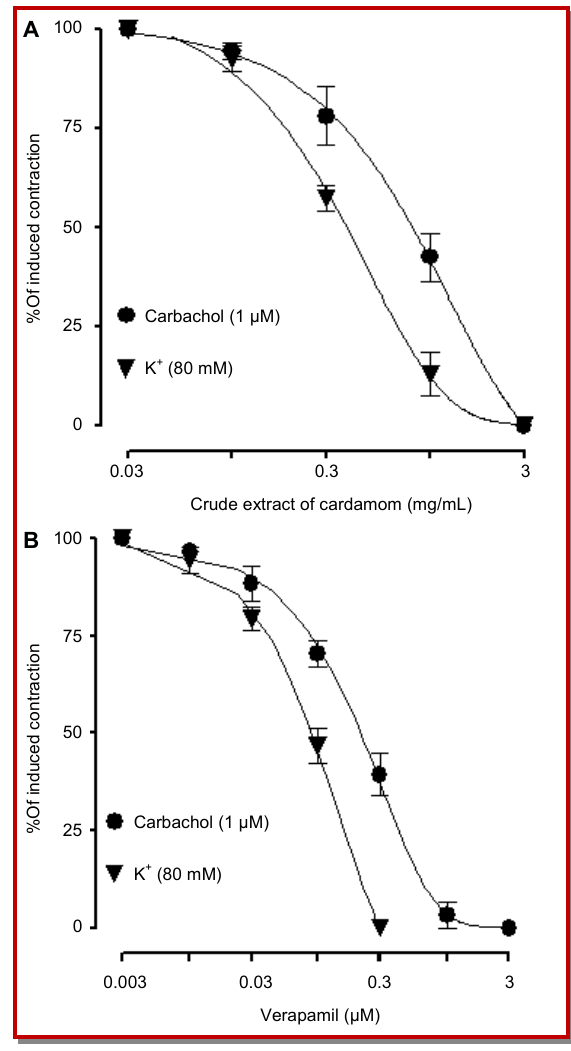
Figure 2: Concentration-dependent inhibitory effect of (A) crude extract of cardamom and (B) verapamil against carbachol and high K + -induced contractions in isolated rabbit tracheal preparations. Values shown are mean ± SEM, n=